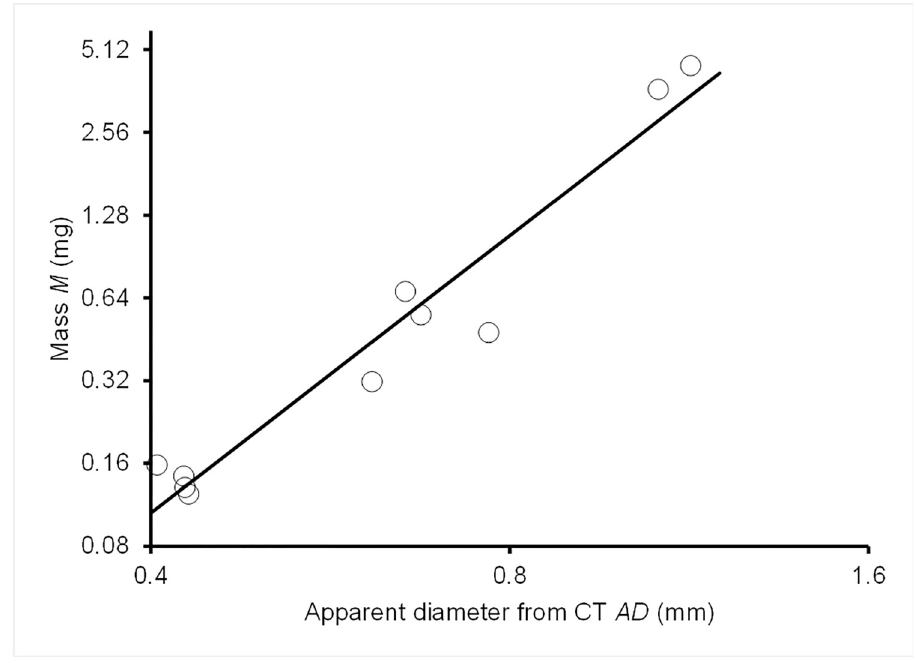
Fig 3. Known mass of lead spheres in relation to their apparent size on a micro-CT scan. Measured mean mass M (mg) of ten batches of lead spheres injected into domestic fowl carcasses in relation to the mean apparent diameter AD (mm) of the same batches of spheres derived from CT images. Both axes are logarithmic but the values shown are not transformed. The line is the ordinary least squares regression fitted to the log-transformed values was log e ( M ) = 0.823 +3.352 log e ( AD